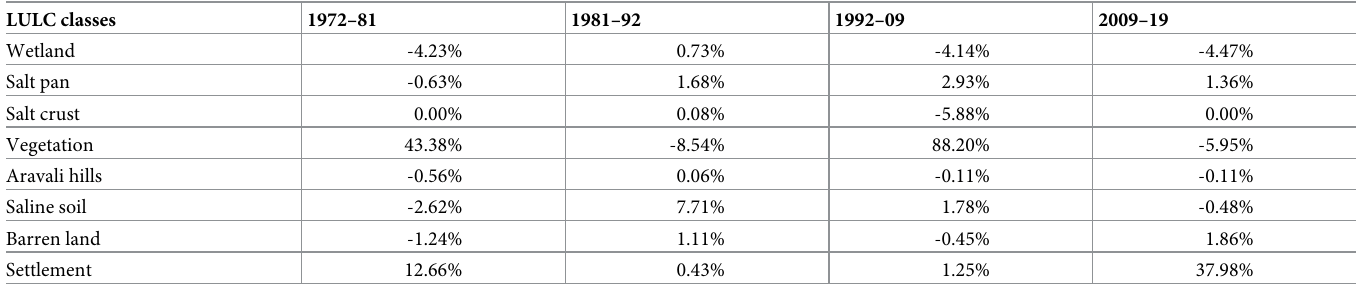
Table 3. LULC dynamic degree K (percentage).